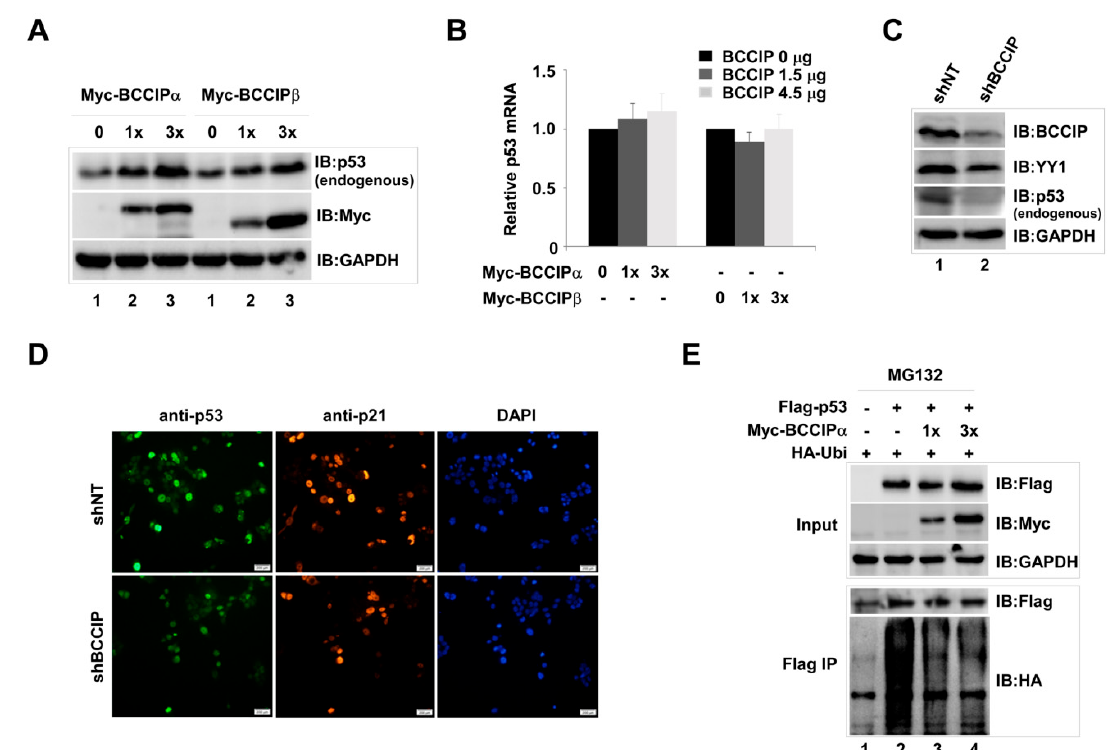
Figure 1. BCCIP stabilized p53 in HCT116 (p53 +/+ ) cells. ( A , B ) Increase in endogenous p53 protein by transfection of BCCIP plasmids. Cells were transfected with 1.5 and 4.5 µ g Myc tagged BCCIP α or BCCIP β plasmids. Endogenous p53 protein in whole cell lysate and p53 mRNA levels were measured 72 h later with western blot methods ( A , GAPDH is an internal control) and RT-qPCR ( B , relative mRNA levels were normalized by GAPDH). ( C , D ) Decrease of endogenous p53 proteins in shBCCIP-treated cells. BCCIP shRNA (2 µ g) and an shNT control was transfected into HCT116 cells. Indicated proteins were detected 72 h after transfection by western blot and cell staining. DAPI staining shows total nuclei. Scale bar indicates 200 µ m. ( E ) Stabilization of exogenous p53 by transfection of BCCIP α plasmids. Cells were co-transfected with Flag-p53 (2.8 µ g), Myc-BCCIP α (1.2 and 3.6 µ g), and HA-ubiquitin (2 µ g) in the presence of MG132 (10 µ M). Exogenous p53 proteins were measured 48 h after transfection by western blot using anti-Flag antibody. The degradation of Flag-p53 was measured with anti-HA antibody.